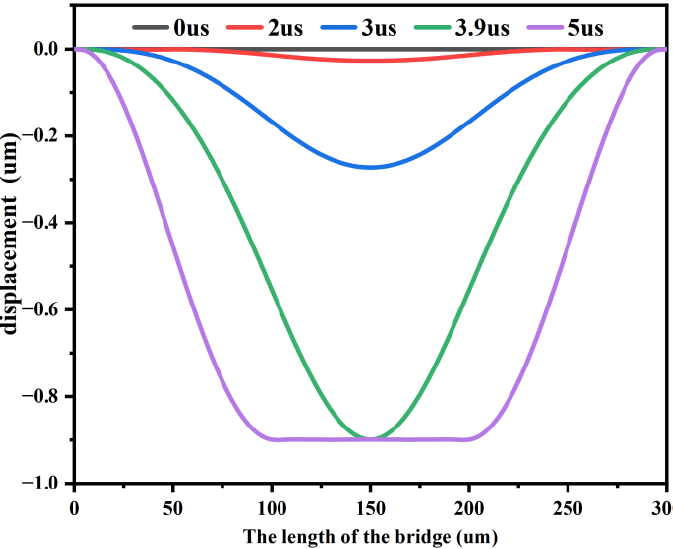
Figure 8. Shape of the beam at different instants of time during pull-down.